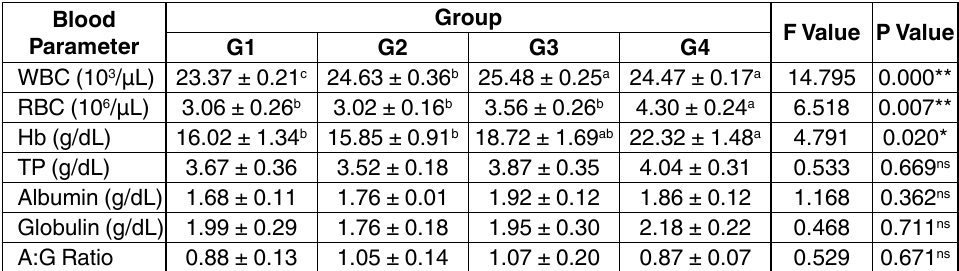
Table 1. Blood biochemical parameters # of birds supplemented with graded levels of C. vulgaris extract Blood Parameter